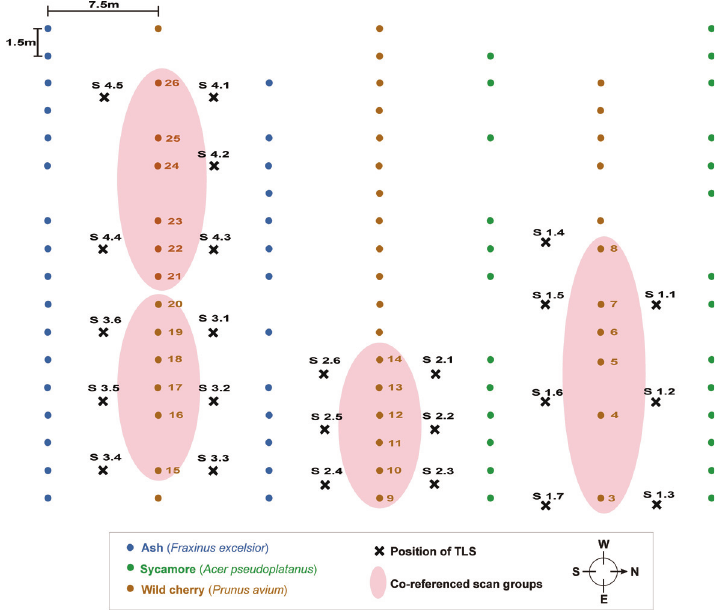
Figure 1. Group III: map of tree rows in the agroforestry system with marked scan positions. TLS, terrestrial laser